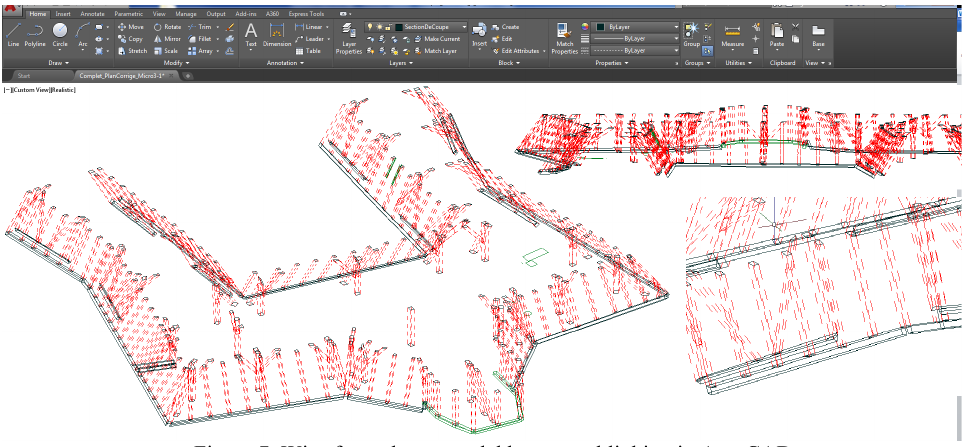
Figure 7. Wire-frame beam model by manual linking in AutoCAD.